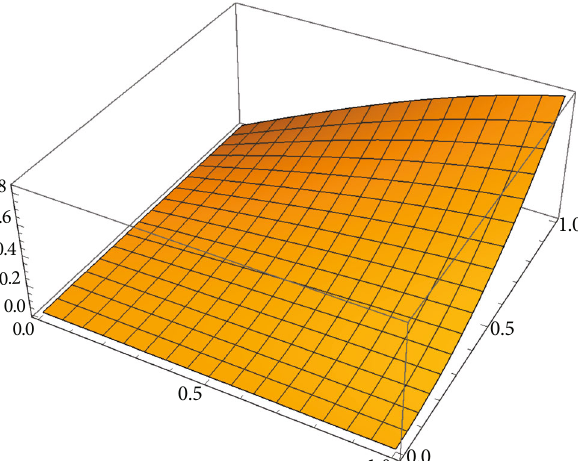
Figure 4: Exact solution for Example